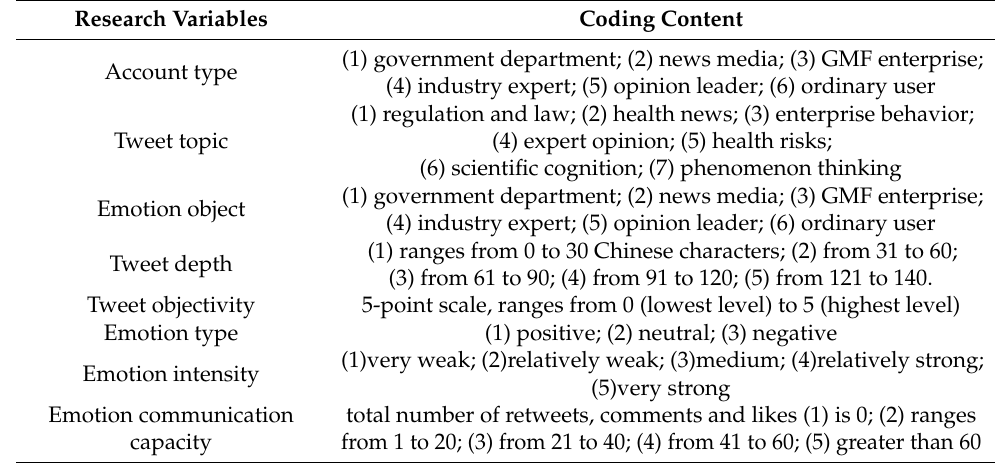
Table 1. Coding table for content analysis of tweets about genetically modified food (GMF)